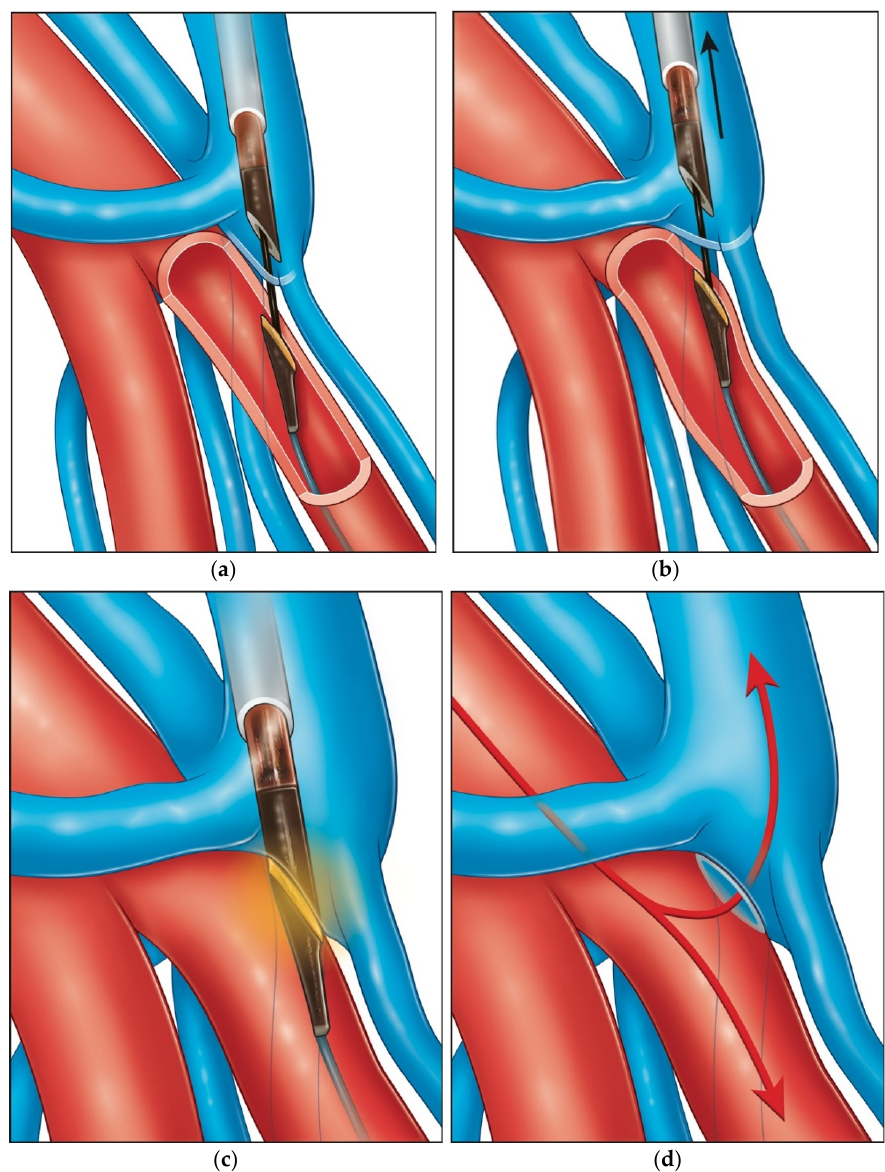
Figure 3. ( a – d ) stages of anastomosis creation with the Ellipsys device between the proximal radial artery and the perforating vein of the elbow—reproduced with permission from Mallios et al. J Vasc Surg [15].